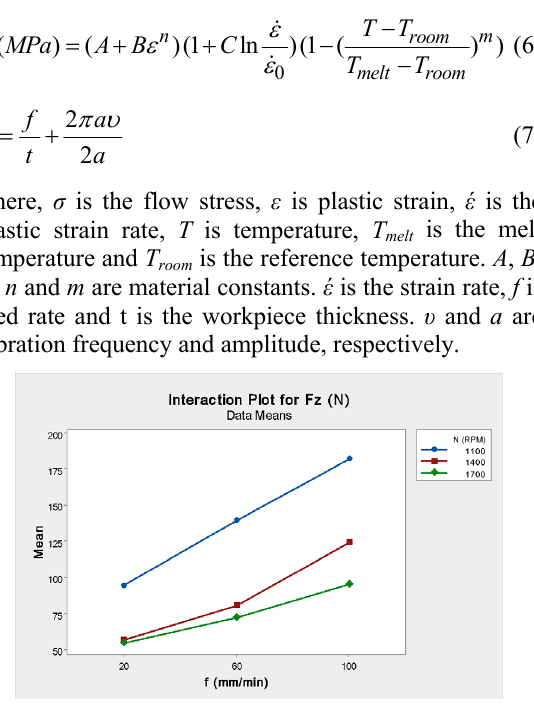
Figure 9. Interactive effect of spindle speed and feed rate on thrust